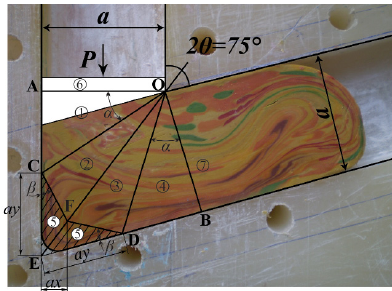
Figure 3. Physical model of the shape of the material dead zone CEDF during ECAE through a Segal 2θ -die with channel intersection angle 2θ=75° after three ECAE passes via deformation route C.